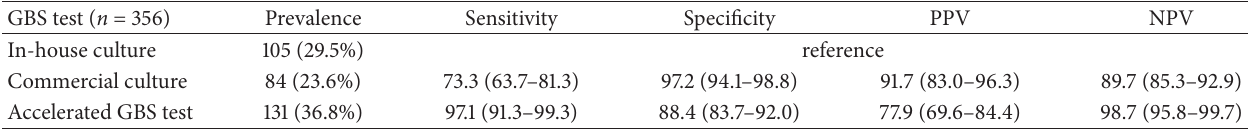
Table 1: Antepartum validity of the accelerated GBS test compared to GBS